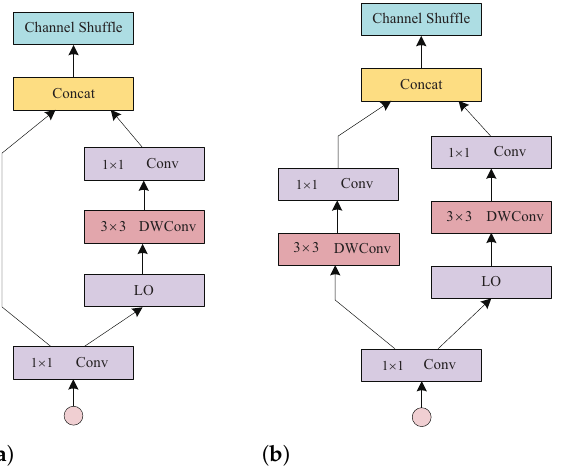
Figure 3. Structural design of GF-Bottleneck. Ghost module consists of normal convolution and linear operations (LO). DWConv represents depthwise separable convolutions. ( a ) Stride = 1 and ( b ) Stride =